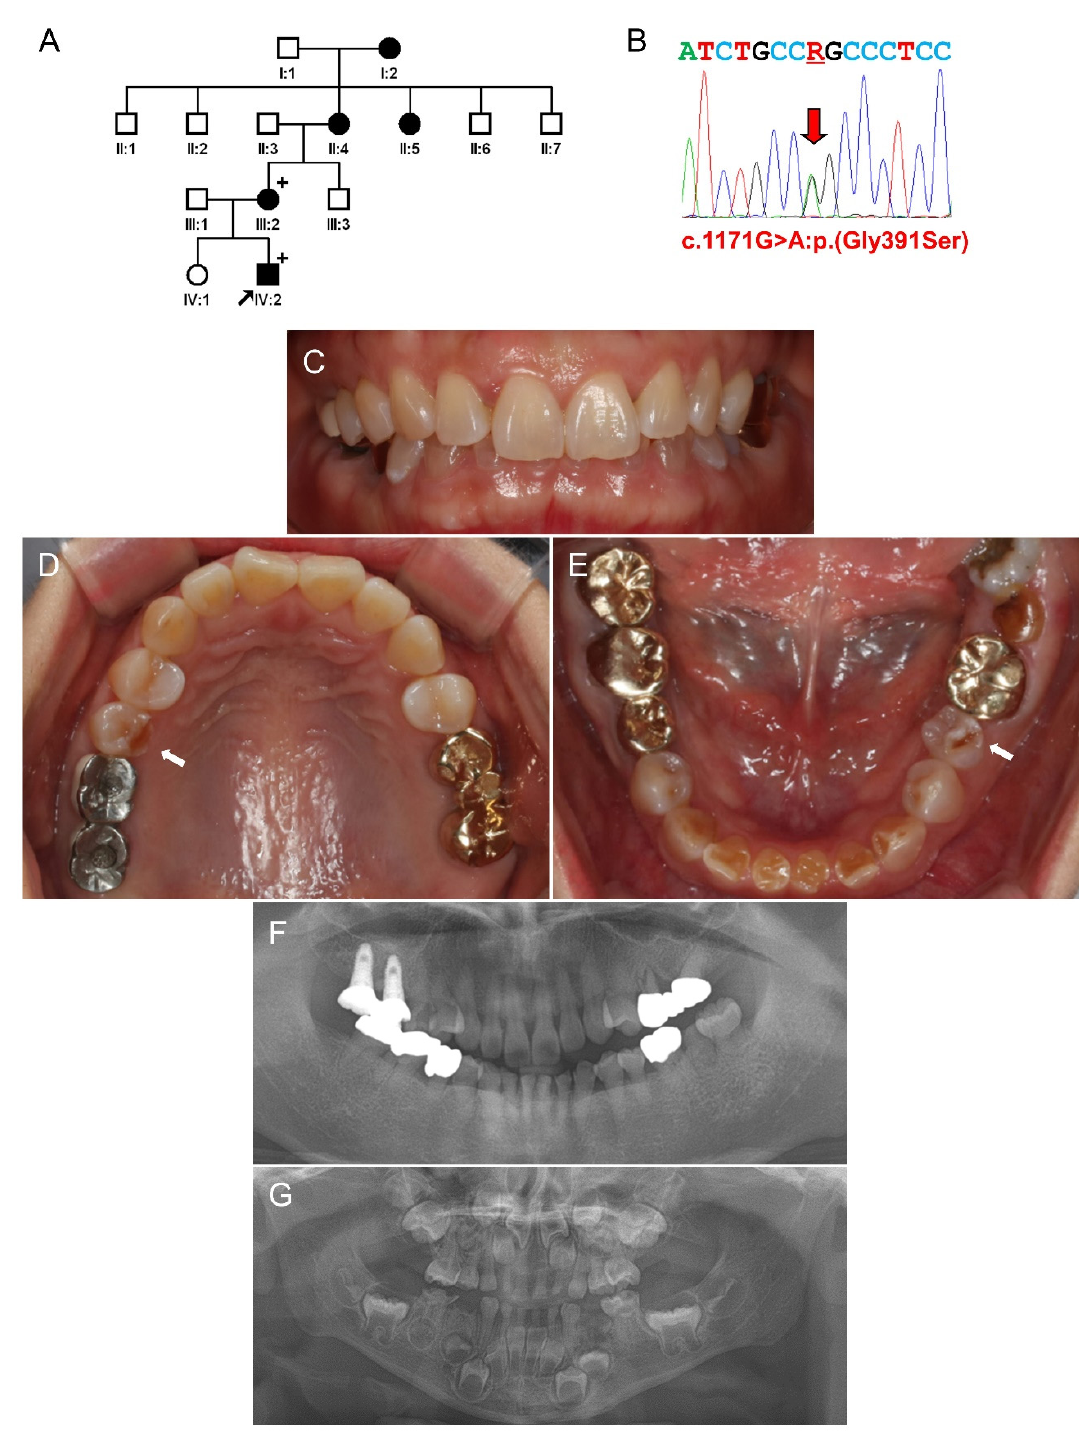
Figure 3. Pedigree, sequencing chromatogram, clinical photos, and panoramic radiograph of Family 3. ( A ) Pedigree of Family 3. The black filled symbol indicates the affected individual, and the proband is indicated by a black arrow. Plus signs above the symbols indicate participating individuals. ( B ) Sequencing chromatogram of the proband. Nucleotide sequences are shown above the chromatogram. The red arrow indicates the location of the mutation (NM_000089.4:c.1171G>A) (R: A or G). ( C – E ) Clinical photos of the proband’s mother at age 37 years. There are some attritions in the mandibular anterior teeth and premolars (white arrow); however, the maxillary anterior teeth look normal. ( F ) Panoramic radiograph of the proband’s mother at age 37 years. ( G ) Panoramic radiograph of the proband at age 4 years and 8 months.